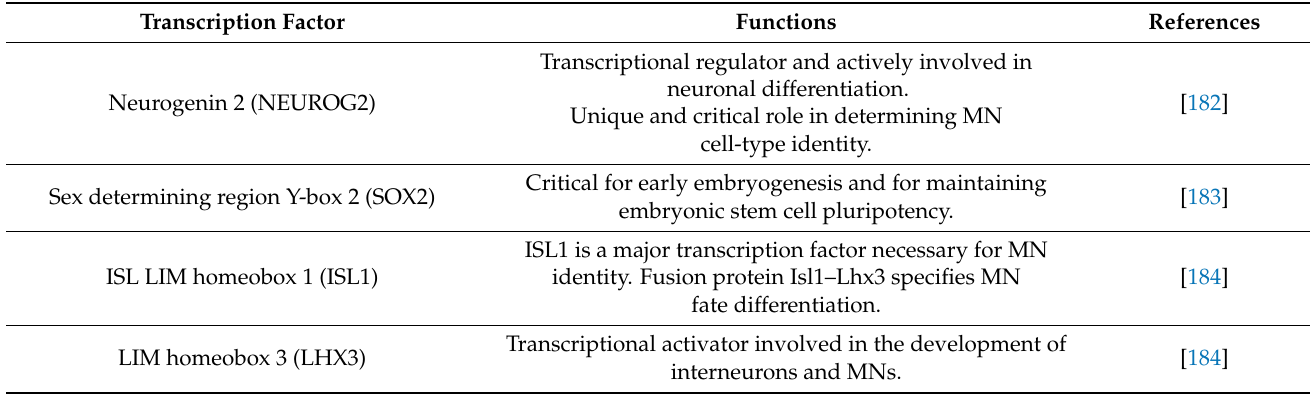
Table 5. Roles of transcription factors in MN